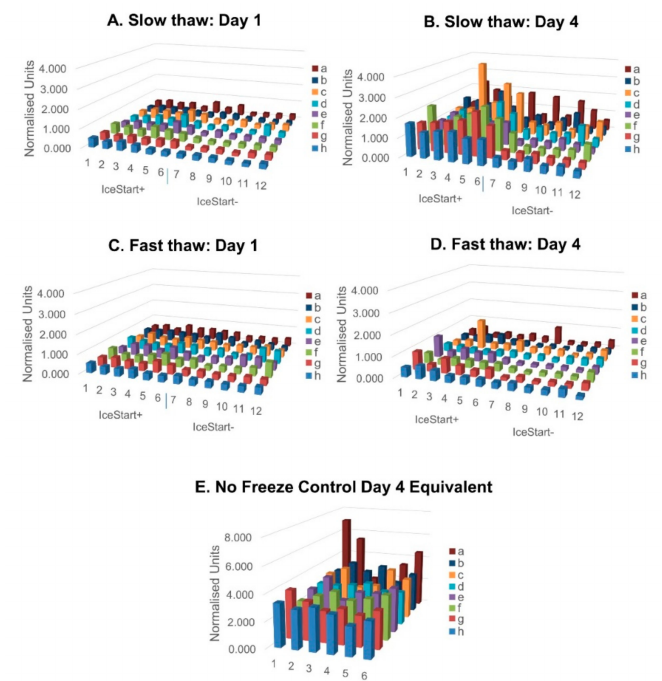
Figure 4. Metabolic activity normalised to Day 1 No Freeze control values for each well, respectively. IceStart + conditions demonstrate greater metabolic activity following thaw with slow thaw conditions recovering to the greatest extent. n = 3 donor repeats. ( A ) Day 1 post thaw MTT slow thaw, ( B ) Day 4 slow thaw, ( C ) fast thaw Day 1, ( D ) Day 4 fast thaw, ( E ) Day 4 equivalent No Freeze control. n = 3 donor repeats for each